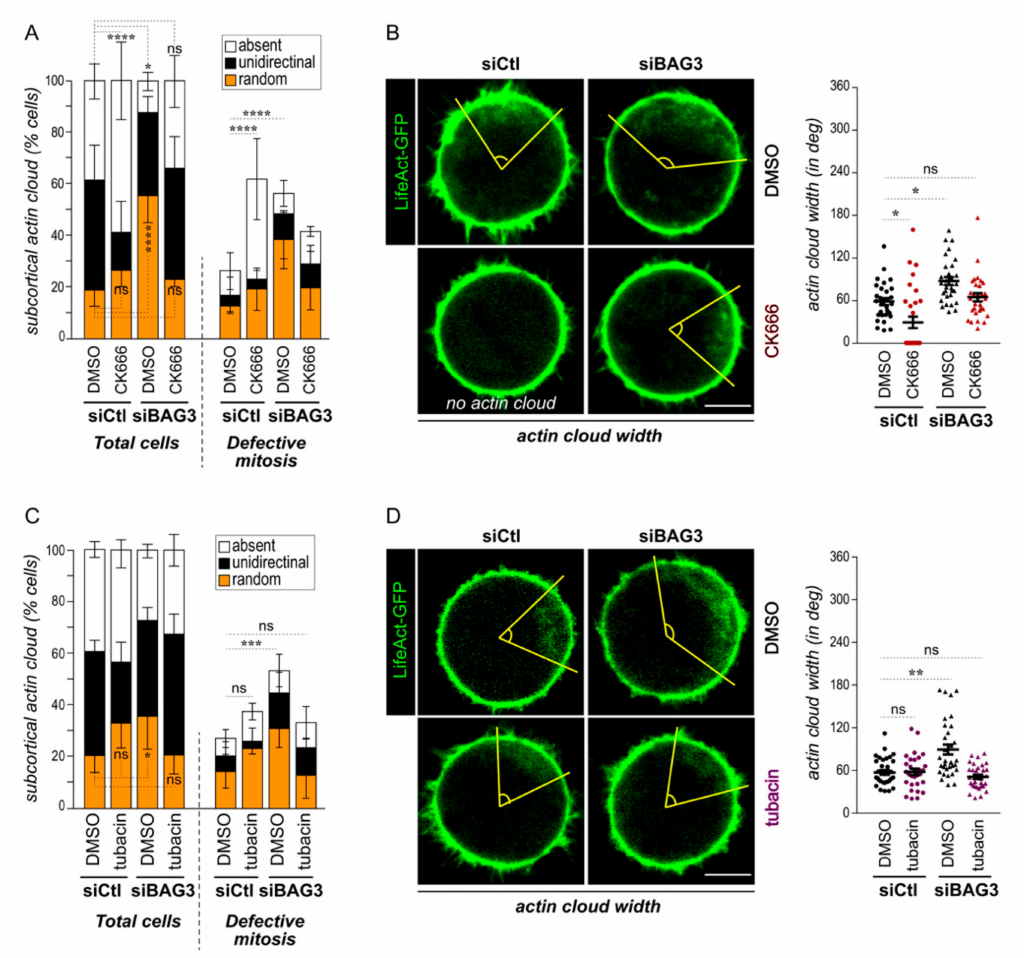
Figure 3. Downregulation of Arp2/3 or HDAC6 activity in BAG3-depleted cells can normalize the actin cloud dynamic. ( A , C ) Quantification of the actin cloud motion from time lapse analyses of HeLa-H2B-RFP cells that have been transfected with the indicated siRNAs and incubated with Arp2/3 inhibitor CK666 (40 µ M; A ) or HDAC6 inhibitor tubacin (20 nM; C ), in total cell populations as compared to cells showing mitotic defects (spindle rocking or delayed in prometaphase); means ± SEM of n = 69 and 146 cells from 2 to 3 experiments. ( B , D ) Representative confocal images showing the organization of the actin cloud; the angular widths are delineated by yellow lines. Scale bars: 10 µ m. Graphs show the actin cloud angular widths in live cells expressing LifeAct-GFP ( left ) or in fixed cells stained with fluorescent phalloidin; data are the means ± SEM of n = 30–34 cells from 2 to 3 independent experiments. Statistical analyses were performed using the Mann–Whitney test; *, p < 0.05; **, p < 0.01, ***, p < 0.001; ****, p <